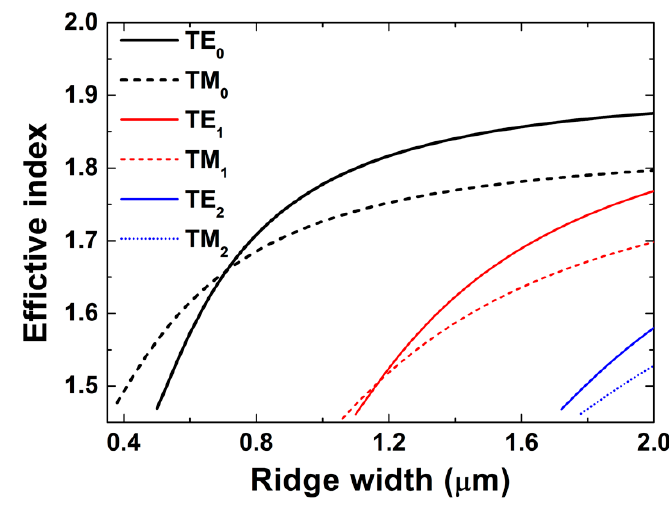
Figure 3. Effective index of the TE (solid lines) and TM (dashed lines) modes in LN waveguides as a function of the width for a 0.5 μ m thick film. The modes were calculated at λ = 1.55 μ m.